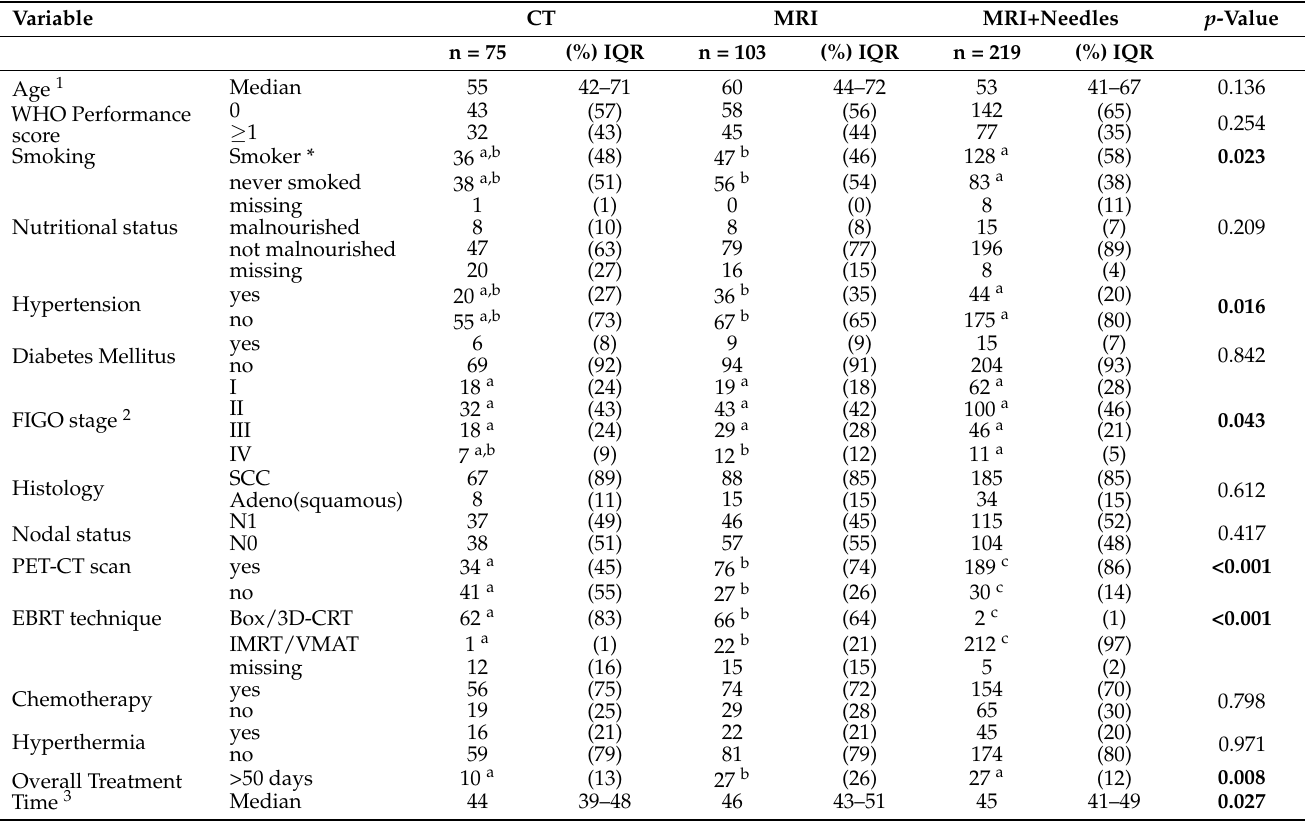
tively. Baseline patient and treatment characteristics by treatment group are shown in Table 1. The median age was 54 years (IQR 42–70). The median follow-up was 40 months (IQR 22–62). Almost all patients had an MRI as part of their diagnostic work-up (366 patients, 92%), and 302 (76%) also had a PET-CT scan. Parametrial interstitial needles were used in 156 of the 219 patients (71%) in the MRI+needles group. Table 1. Baseline patient and treatment characteristics per treatment